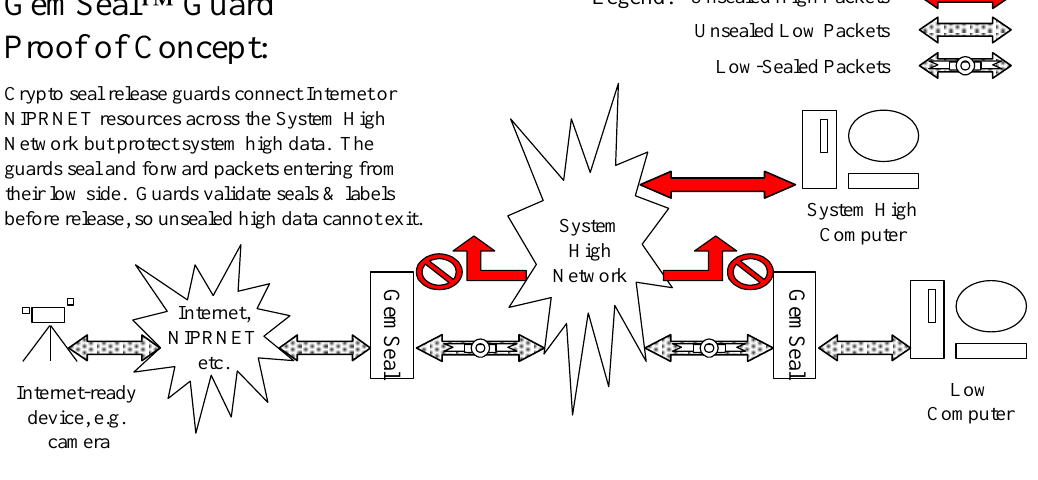
Figure 6. GemSeal guard architecture.